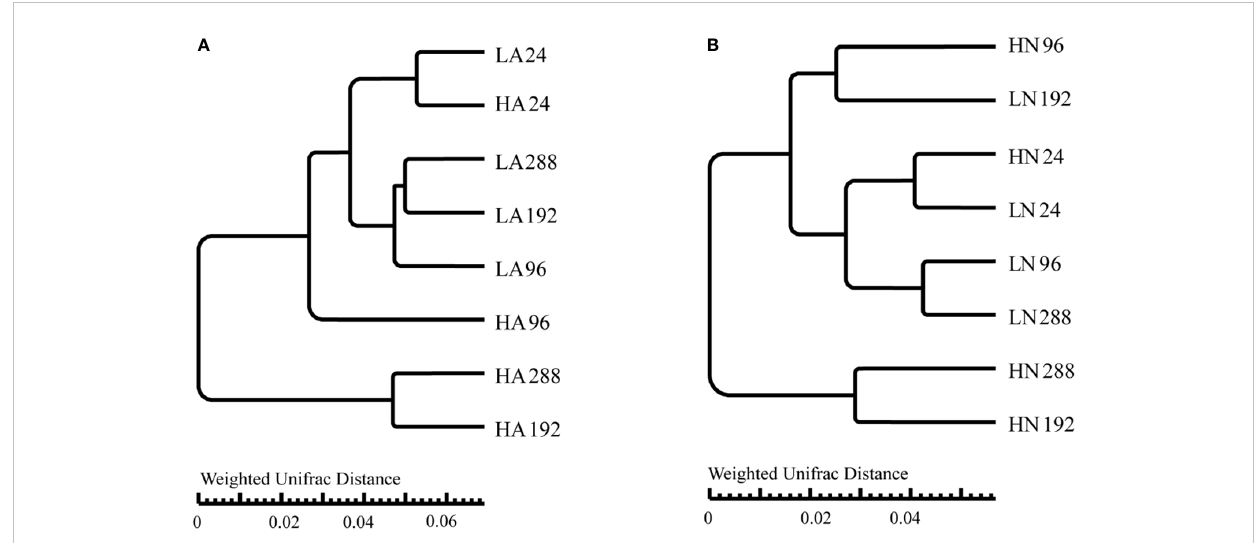
FIGURE 3 UPGMA analysis of different treatment groups under the algal-bacteria co-culture system, using the weighted Unifrac distance (each leaf represents three independent experiments). (A) UPGMA analysis of the comparison between the low concentration (LA) and the high concentration (HA) groups with ammonium. (B) UPGMA analysis of the comparison between the low concentration (LN) and the high concentration (HN) groups with